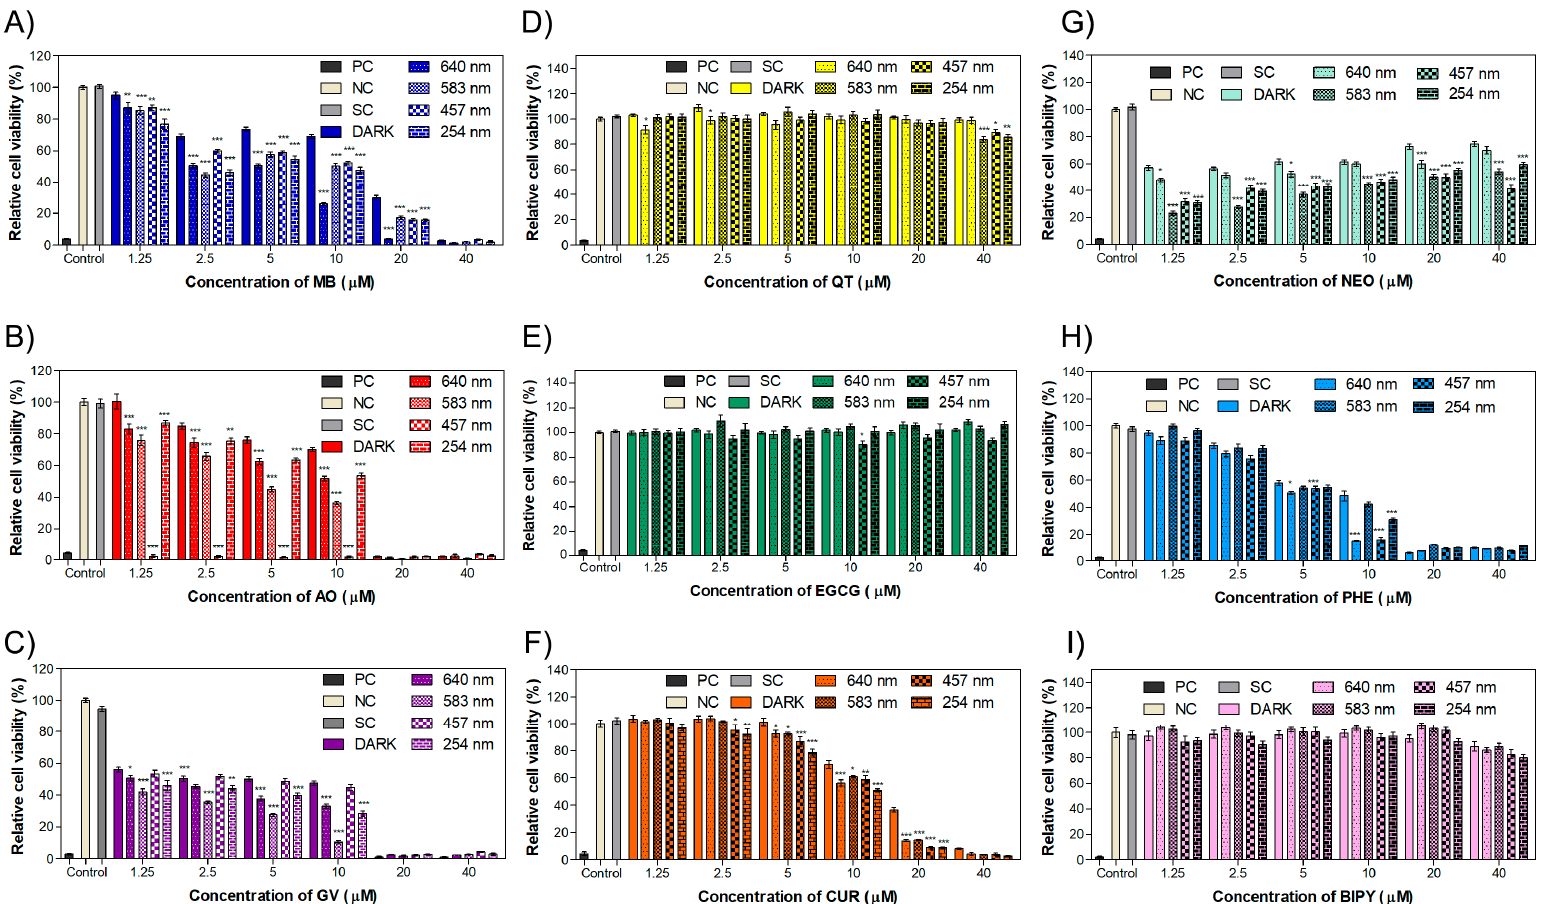
Figure 3. Relative cell viability of the MET1 cell line treated for 24 h with dyes ( A ) MB, ( B ) AO, ( C ) GV; natural compounds ( D ) QT, ( E ) EGCG, ( F ) CUR; or chelating agents ( G ) NEO, ( H ) PHE, ( I ) BIPY and submitted to irradiation. Samples kept in the dark were used as controls and compared to those submitted to irradiation at different wavelengths. Values are presented mean ± combined standard uncertainty ( n = 6), and statistical analysis comparing the results to the dark control was performed with a two-way ANOVA with Bonferroni post test, where * p < 0.05, ** p < 0.01 and *** p < 0.001. MB: methylene blue, AO: acridine orange, GV: gentian violet, QT: quercetin, EGCG: epigallocatechin gallate, CUR: curcumin, NEO: neocuproine, PHE: 1,10-phenanthroline, BIPY: 2,2 (cid:48) -bipyridyl, PC: positive control, NC: negative control, SC: solvent